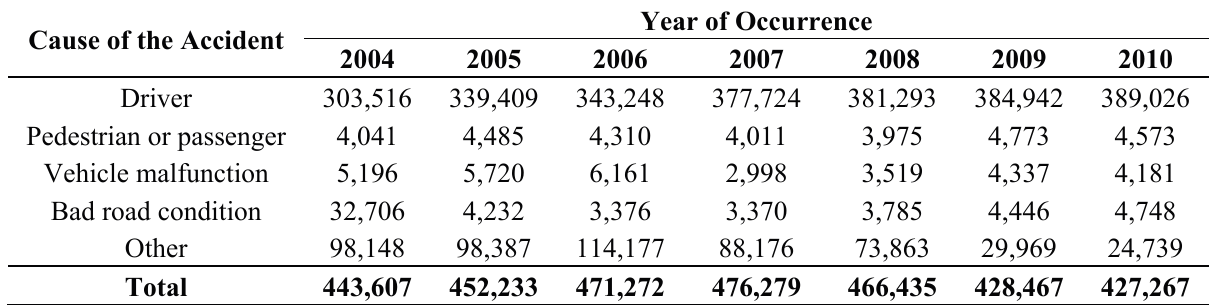
Table 1. Quantity of vial incidents on highway in Mexico. According to the statistics of the National Geographic Institute of Statistics and Informatics (INEGI,